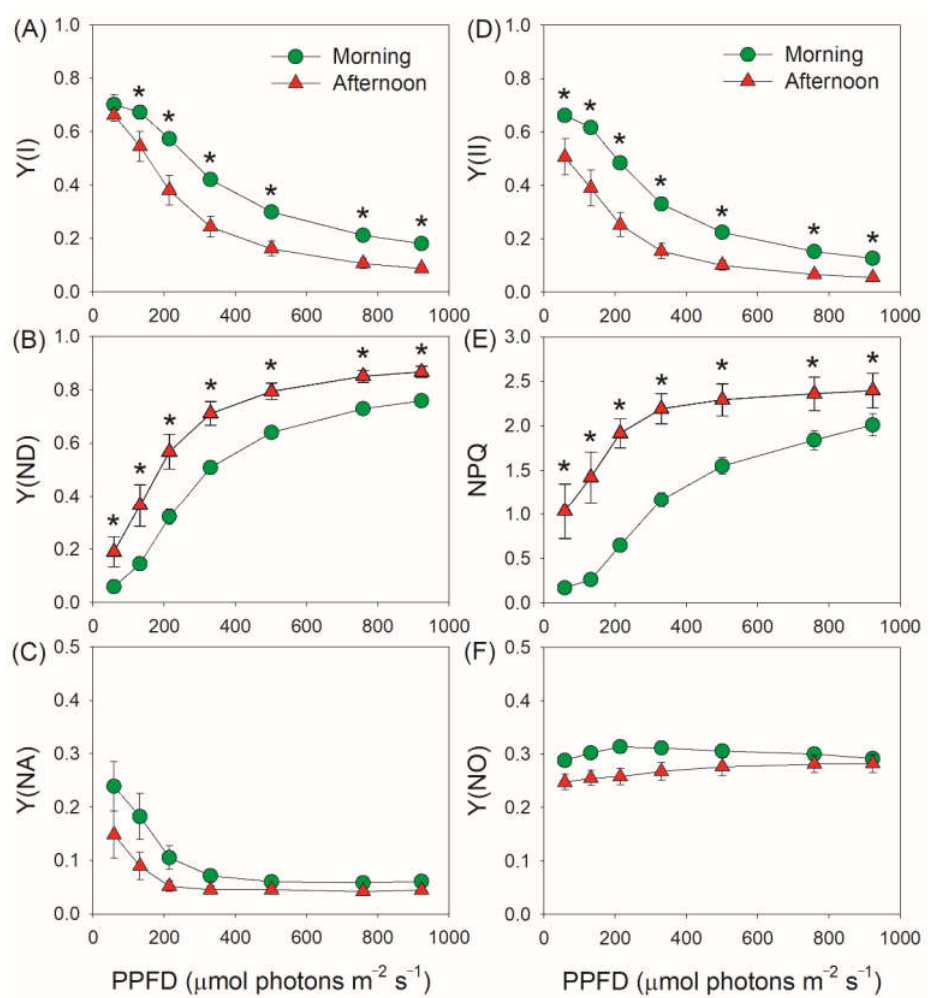
Figure 1. Light intensity dependence of PSI and PSII parameters for leaves of Vanilla planifolia measured in the morning and in the afternoon. Y(I) ( A ), the quantum yield of PSI photochemistry; Y(ND) ( B ), the quantum yield of PSI non-photochemical energy dissipation due to donor side limitation; Y(NA) ( C ), the quantum yield of PSI non-photochemical energy dissipation due to acceptor side limitation; Y(II) ( D ), the quantum yield of PSII photochemistry; NPQ ( E ), non-photochemical quenching in PSII; Y(NO) ( F ), the quantum yield of non-regulatory energy dissipation in PSII. Data are means ± SE ( n = 5). Asterisk indicates a significant difference between morning and